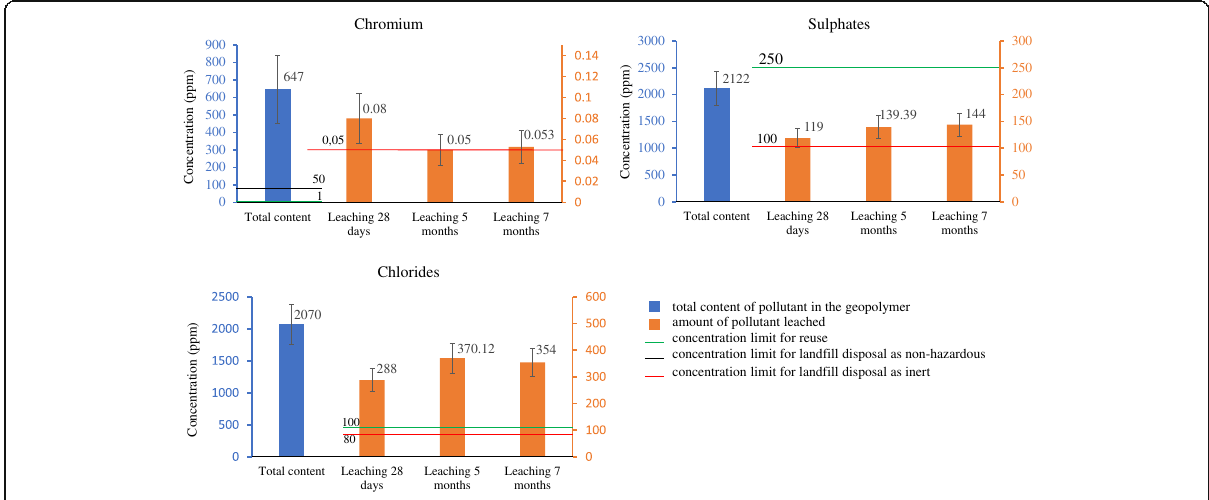
Fig. 4 Main pollutants comparison after leaching tests on the MK produced using tannery wastewater concentrated 2:1 via evaporation. Limits shown refer to the current Italian regulation. All values are reported in